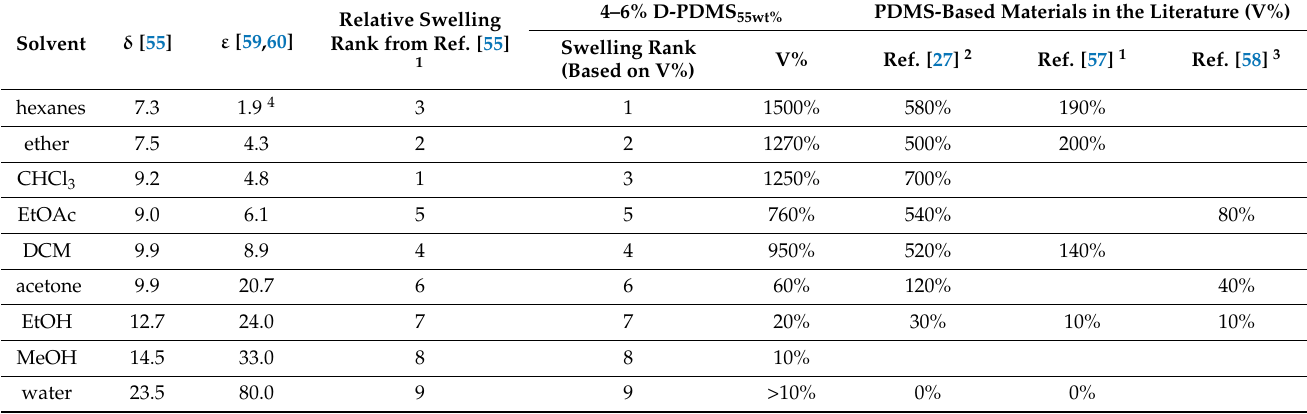
Table 3. Solvent Hildebrand solubility parameter ( δ ), dielectric constant ( ε ), and swelling ranking based on volume (where 1 is best) for 4–6% D-PDMS 55wt% and other crosslinked poly(dimethylsiloxane) (PDMS)